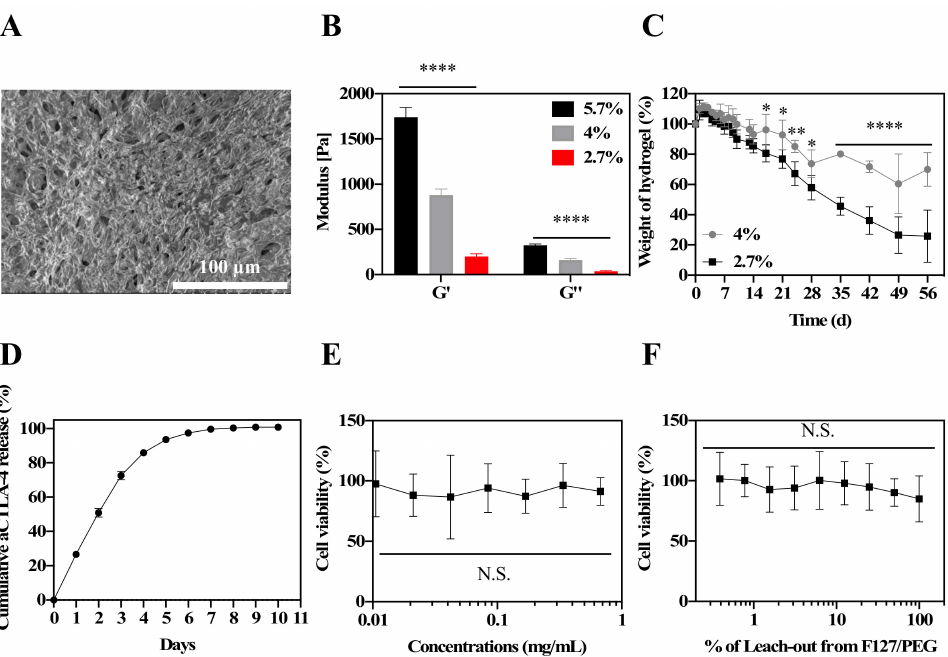
Figure 1. Characterization of in situ crosslinked F127/PEG hydrogel. ( A ) SEM images of F127/PEG hydrogel. ( B ) Rheology of F127/PEG hydrogels. ( C ) In vitro stability of F127/PEG hydrogels. ( D ) In vitro antibody (Alexa Fluor™ 647-labeled aCTLA-4) release from 2.7% ( w / v ) F127/PEG hydrogels. ( E ) Cytotoxicity of F127/PEG polymers on NIH3T3 cells. ( F ) Cyto- toxicity of F127/PEG hydrogel leach-out extracts on NIH3T3 cells. **** p < 0.0001, *** p < 0.001, ** p < 0.01, and * p < 0.05, which were analyzed with a one-way ANOVA test for ( B ), ( E ), and ( F ), and a two-way ANOVA test for ( C ).